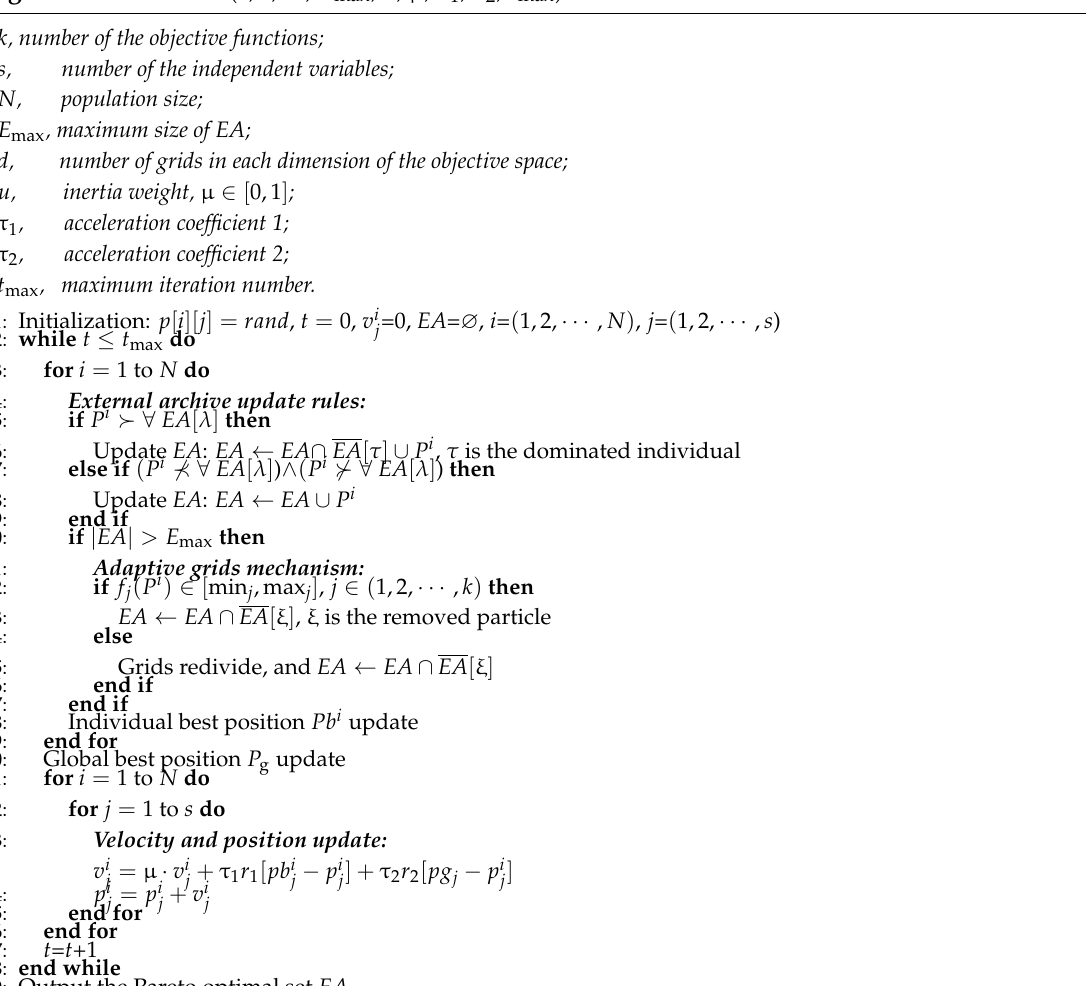
Algorithm 1: MOPSO ( k , s , N , E max , d , µ , τ 1 , τ 2 , t max